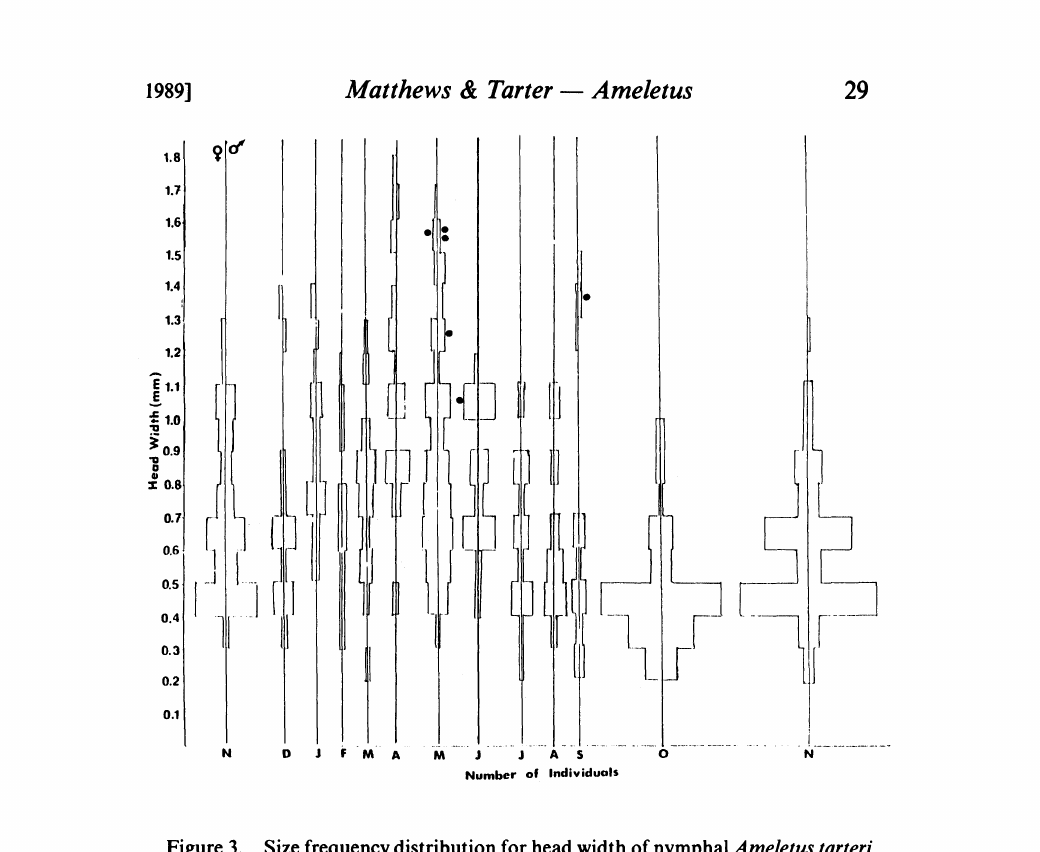
Figure 3. Size frequency distribution for head width of nymphal Ameletus tarteri from Carpenter Run, Greenbrier County, West Virginia, from November 1986 to November 1987. Sex is indicated for nymphs with a head width greater than 1.1 mm. Closed circles represent black wing pads. hatch, accounting for the increased relative abundance at this